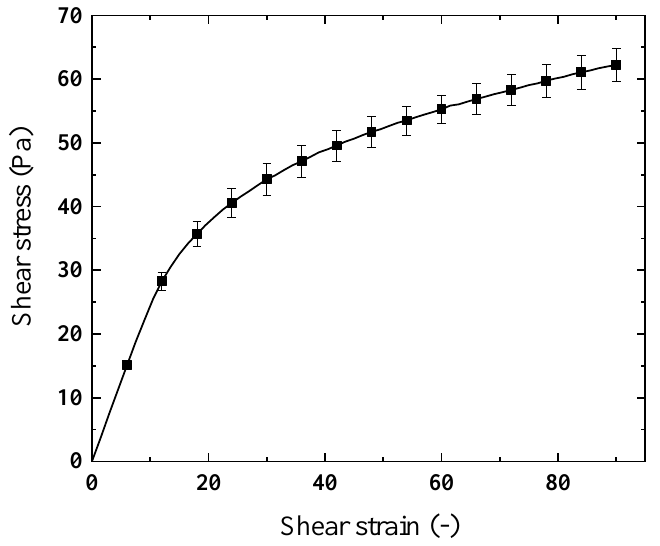
Figure 2. Yield stress (with standard deviation) of the kerosene gel with 5% organic gellant. It should be mentioned that the yield stress values are obtained by measuring the stress–strain curve with a very low level of shear rate where the gel behaves almost as a solid material. Typically, yield stress is measured to fit the thixotropic property described by Equation (2), where the equilibrium shear viscosities at various shear rates are required. For a thixotropic fluid, the equilibrium shear viscosity refers to the viscosity when the shear time is long enough until the value does not change under the action of a specific shear